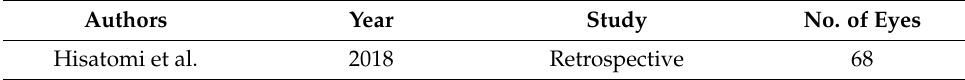
Table 4. Three-dimensional OCT.